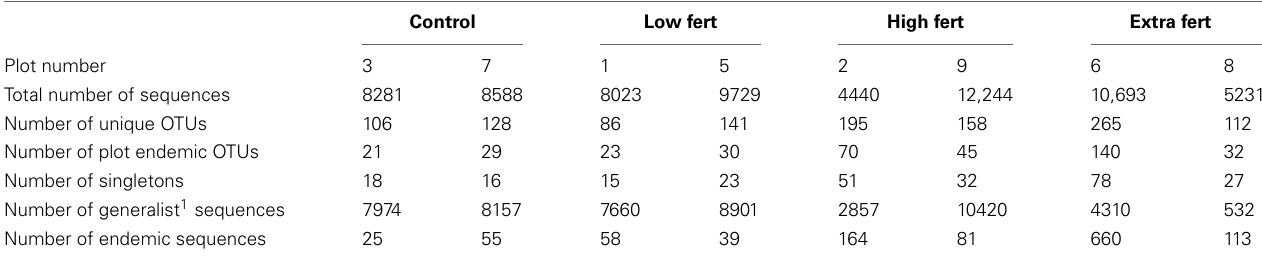
Table 1 | Number of total sequences, total number of unique OTUs, and number of plot endemic OTUs, along with the number of singletons, the number of generalist sequences, and the number of endemic sequences found in each of the salt marsh plots when clustered at 88% sequence